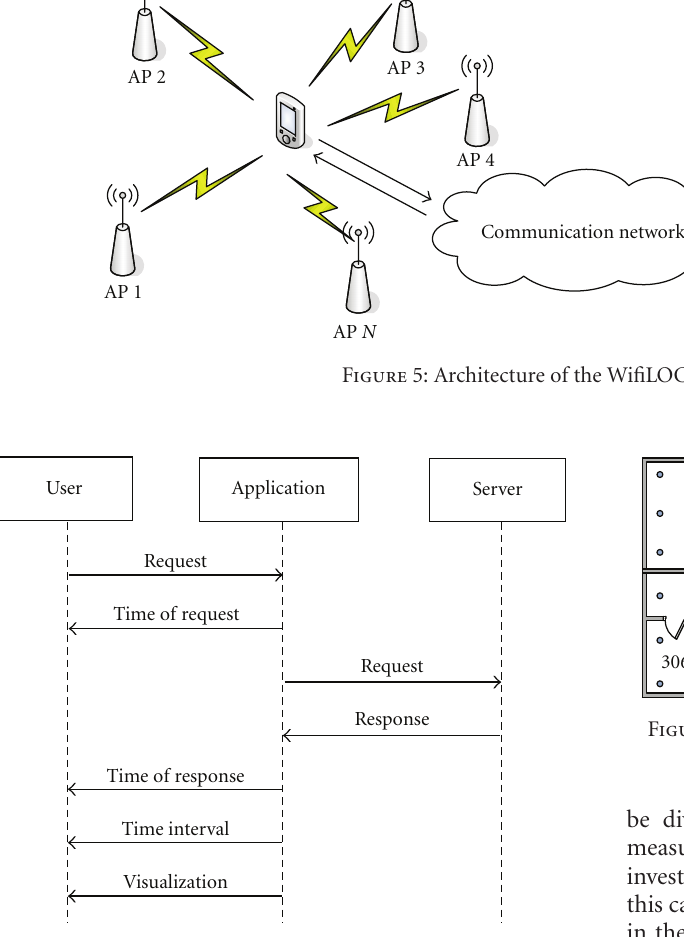
Figure 6: Sequence diagram for the time measurements.